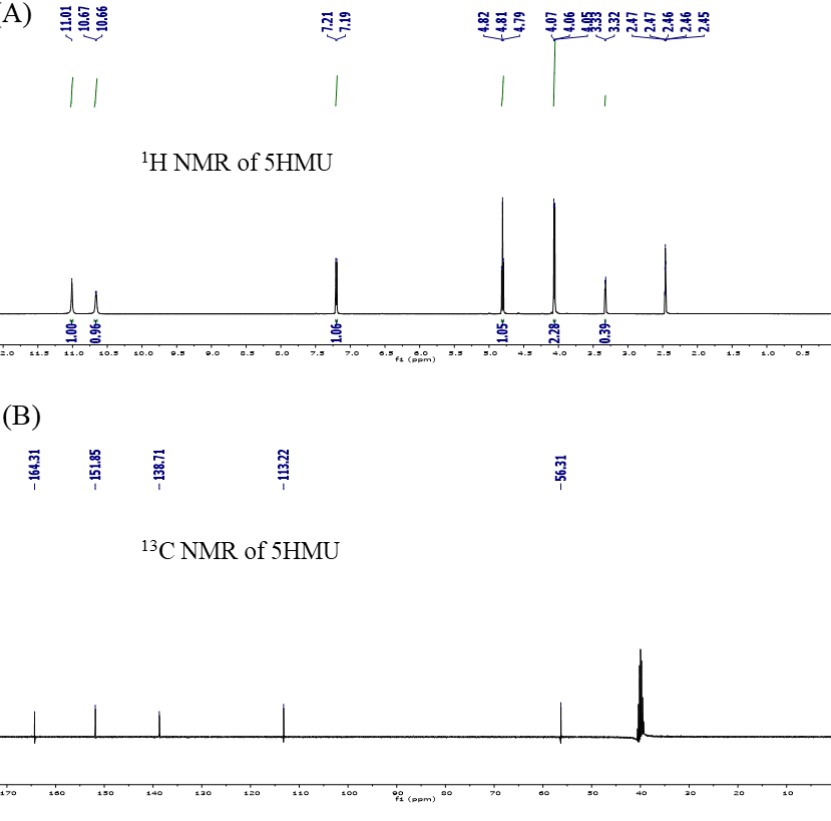
Figure 3. ( A ) Experimental 1 H and ( B ) 13 C NMR of 5-HMU in DMSO- d 6 as a solvent. Table 3 . Experimental and theoretical 13 C and 1 H chemical shift values (ppm) of 5-HMU in DMSO .